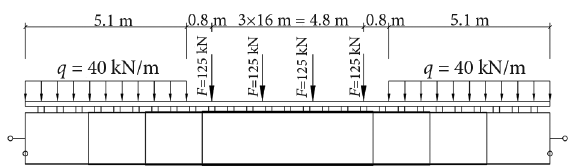
Fig. 10. Load Model 71 applied to the analyzed bridge model